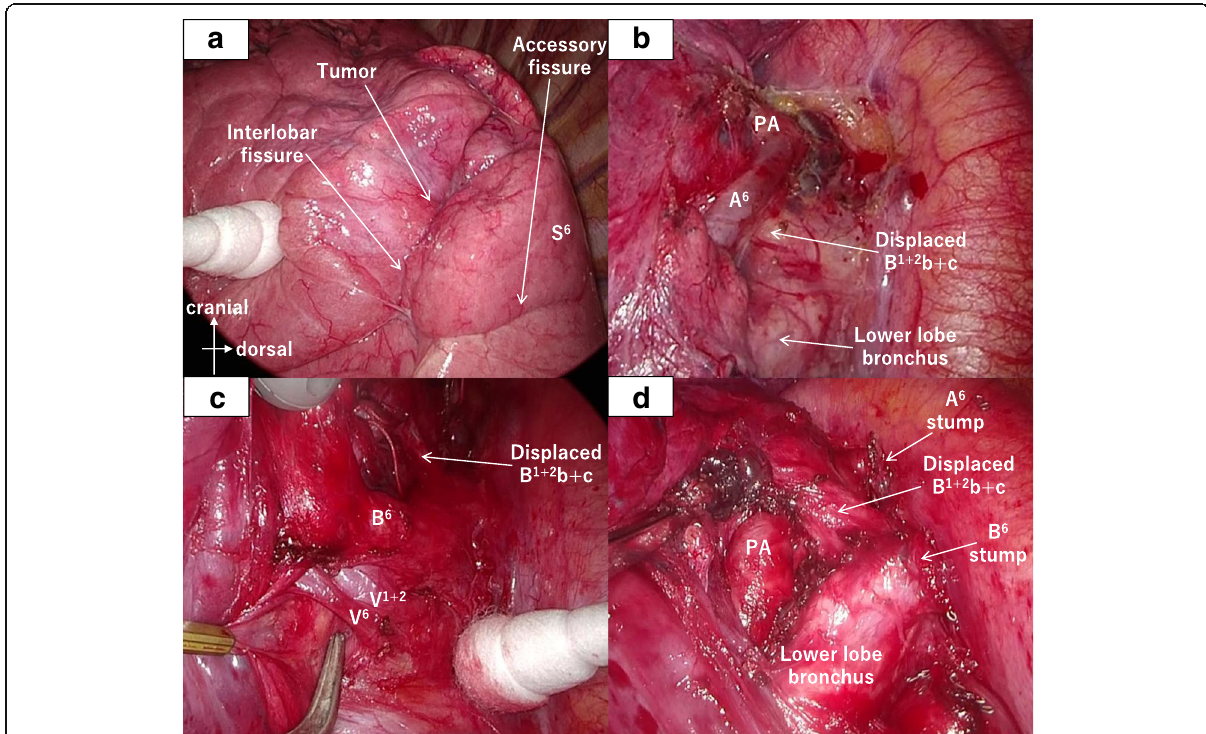
Fig. 4 Intraoperative findings. There are incomplete accessory fissures between S 1+2 and S 3 and between S 6 and the basal segment ( a ). The branch of A 6 arises from the more proximal point than a normal anomaly and passes to the dorsal side of the displaced B 1+2 b+c ( b ). The branch of V 1+2 passes between B 6 and the bronchus to the basal segment and joins V 6 at the dorsal side of the pulmonary hilum ( c ). The displaced B 1+2 b+c passes to the dorsal side of the main pulmonary artery ( d )